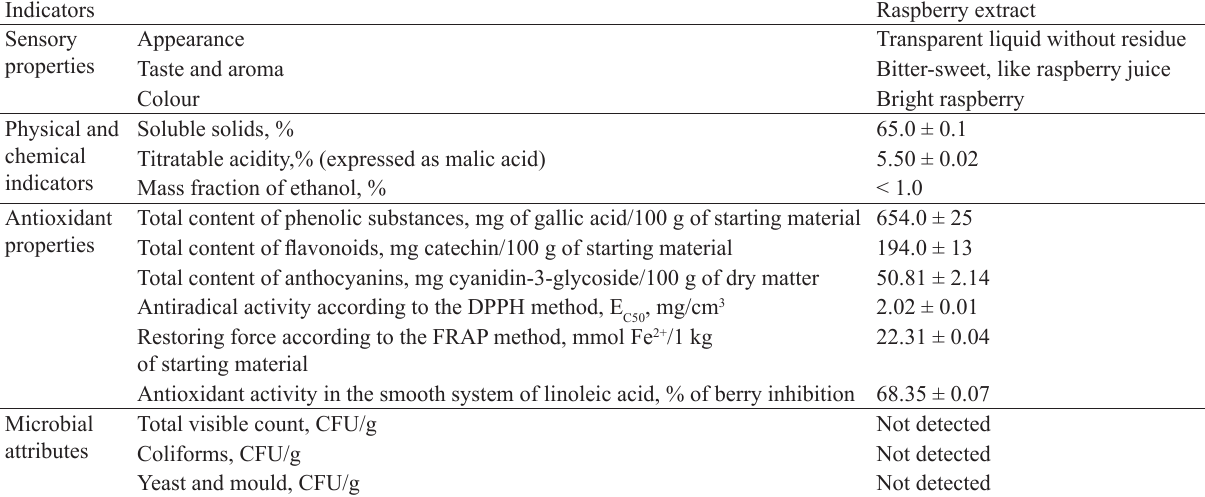
Table 3 Properties of the raspberry extract Indicators